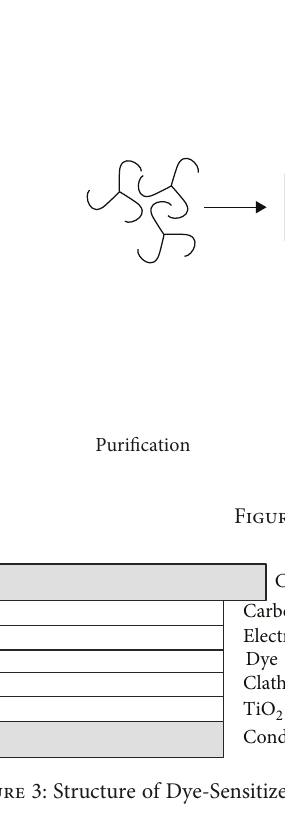
Figure 1: Clathrin protein [13].